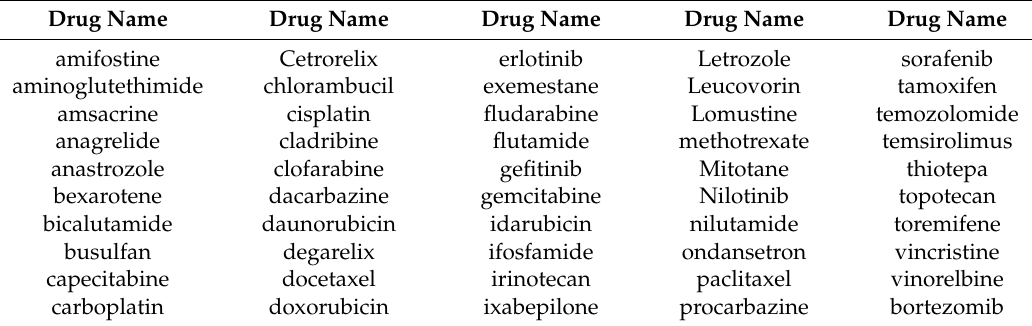
Table 1. List of selected